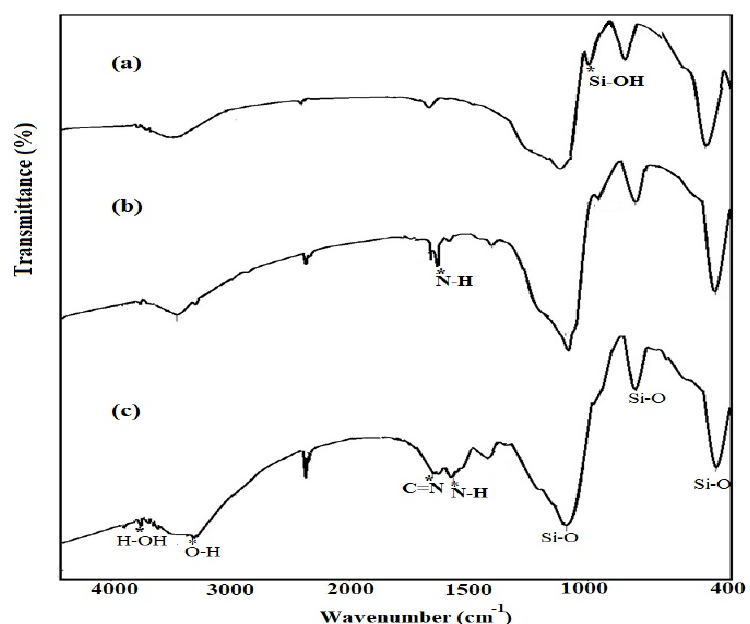
Figure 1. Fourier transform infrared spectroscopy (FTIR) spectra of ( a ) AS, ( b ) STHc and ( c ) STHa.